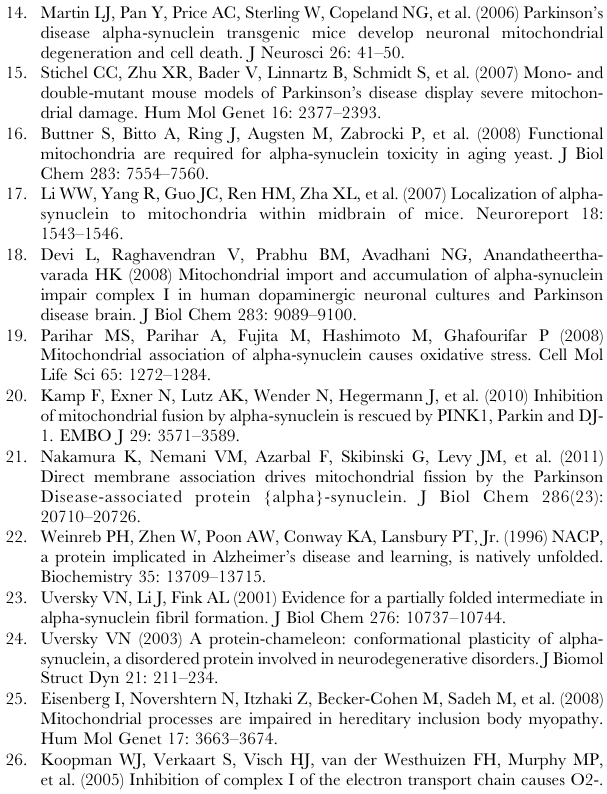
Figure S3 a -Synuclein overexpression promotes its mitochondrial localization in PC12 cells. Further amplified images of Figure 4A demonstrate that a -synuclein overexpression increases its mitochondrial localization in PC12 cells.